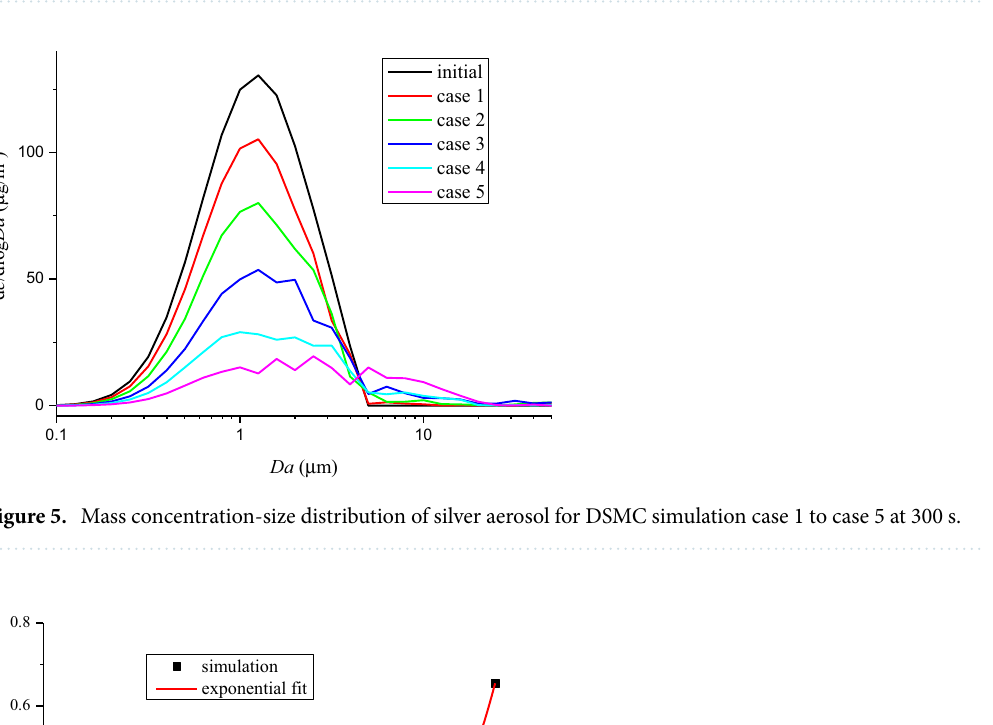
Figure 4. Number concentration-size distribution of silver aerosol for DSMC simulation case 1 to case 5 at 300 s.